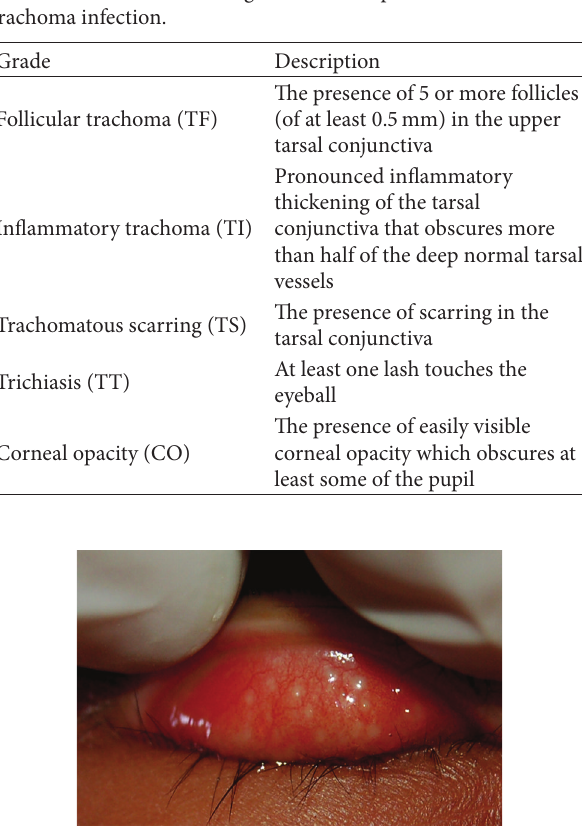
Figure 5: Follicular trachoma (TF stage). Figure courtesy of Holl- man Miller, Vaup´es, Colombia.